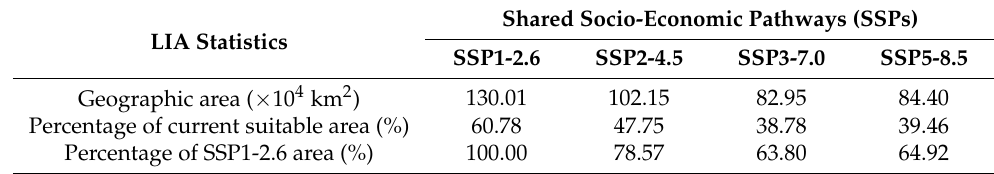
Table 3. Low impact areas (LIAs) under different shared socio-economic pathways (SSPs).